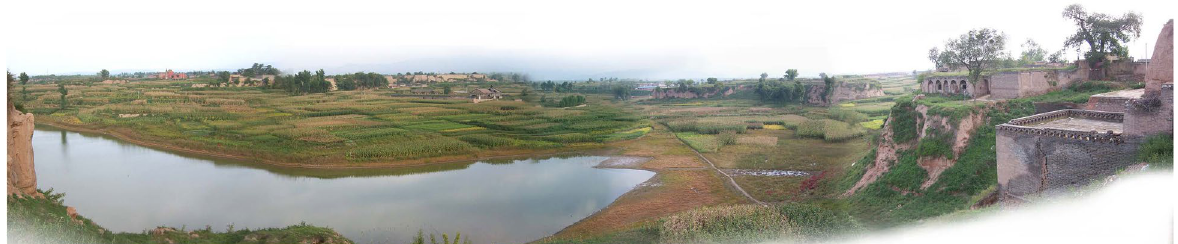
Fig. 6 Spatial pattern of ‘living on the terrace and farming in the valley’ (Source: Tongji University and Ecole de Chaillot 2010)